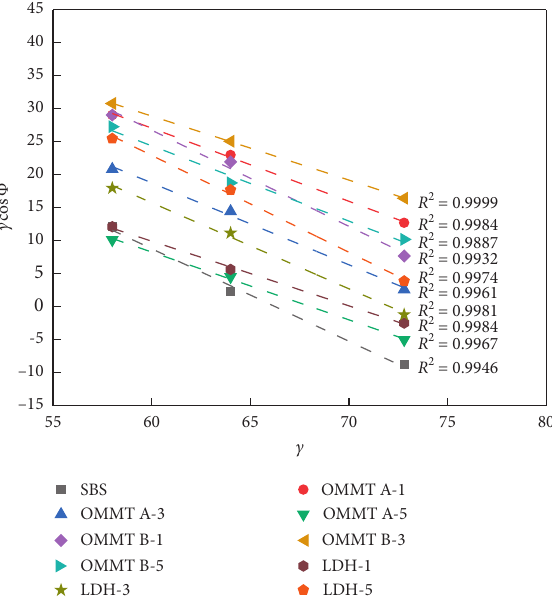
Figure 4: Plot of c cos Φ versus c .